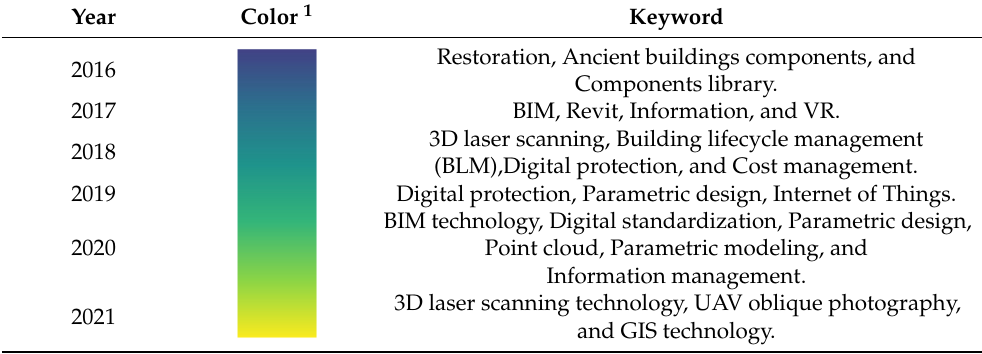
Table 3. Hot research keywords for“BIM” and“Architectural heritage” are overlaid with visualiza- tions, created by